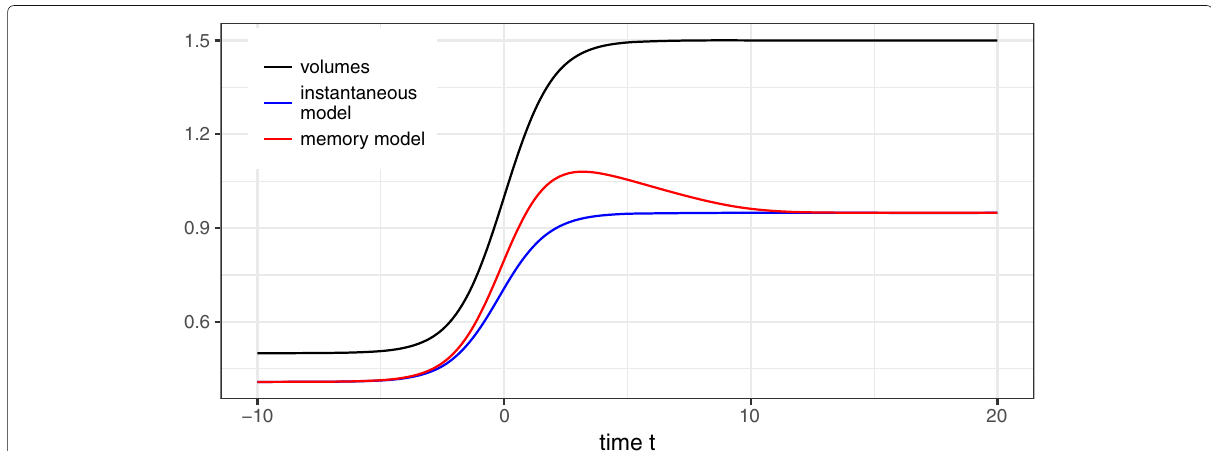
Fig. 1 Schematic illustration of the memory model (2). Including a memory τ > 1 has the effect of an inert response [cf. red curve] to an increase in bicyclist volumes around t = 0 [black curve]. The model’s output for τ = 1 is shown as a reference [blue